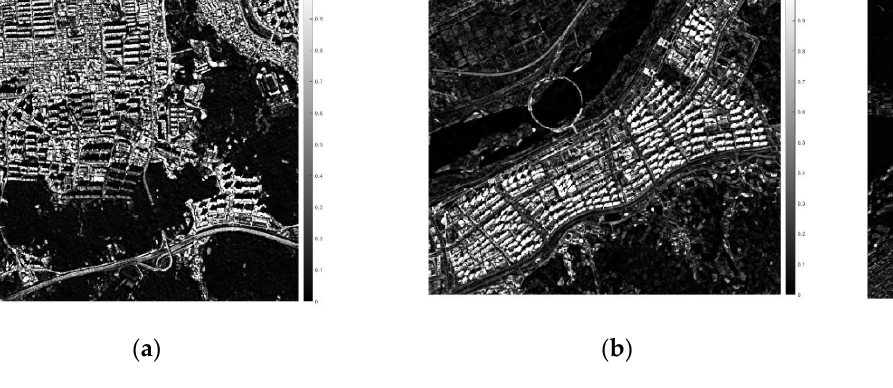
Figure 7. Morphological building index images: ( a ) Site 1; ( b ) Site 2; and ( c ) Site 3 imagery.